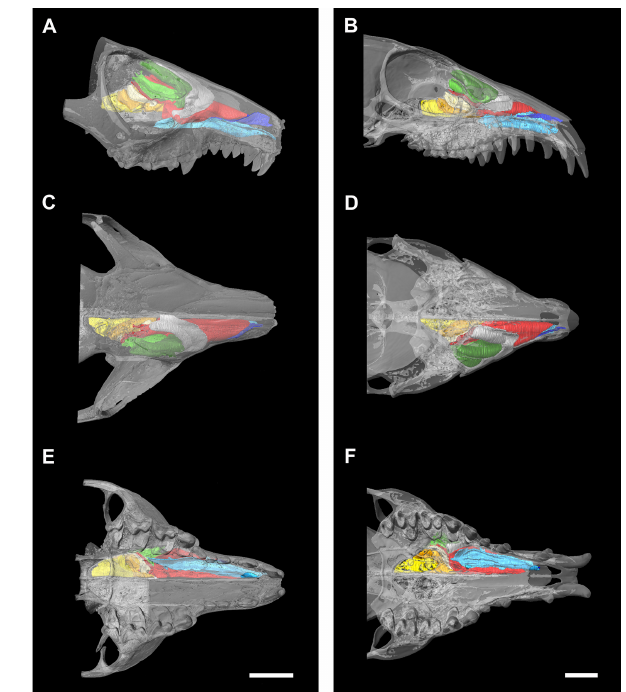
Figure 3. Virtual three-dimensional models of the adult rostrum of (a , c , e) Ptilocercus lowii (ZMB 3992) and (b , d , f ) Tupaia sp. (collection W. Maier): (a) and (b) left lateral view, (c) and (d) dor- sal view, (e) and (f) ventral view. Skull bones are made translucent to allow view on reconstructed turbinal skeleton highlighted in the same colour code as in Fig. 4. Scale bars equal